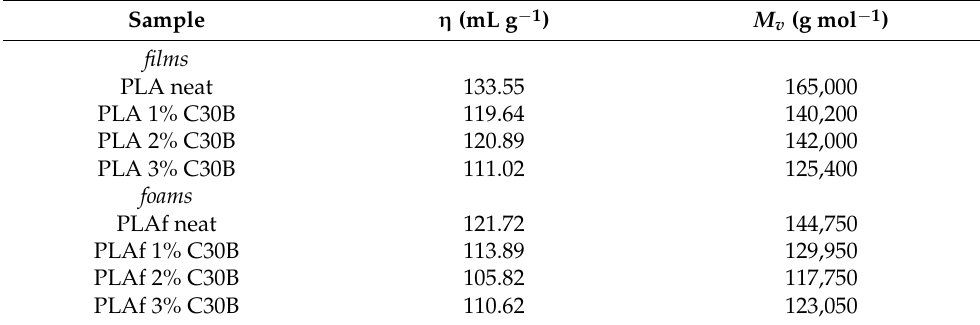
Table 1. Mean values for intrinsic viscosity ( η ) and molecular weight (M v ) of the PLA and PLA bionanocomposite films and foams